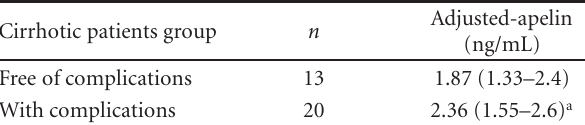
Table 3: Adjusted-apelin levels among cirrhotic patients group ( n = 33).